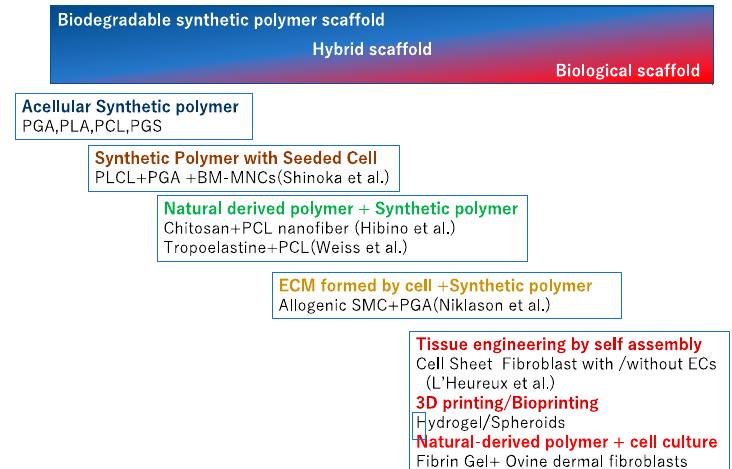
Figure 1. Graft classification by scaffold materials in animal model and clinical studies. Various combinations of biological-based scaffolds and biodegradable synthetic-based scaffolds have been developed and evaluated in large animal models and clinical studies. BM-MNCs, bone marrow mononuclear cells; EC, endothelial cell; PCL, poly ( ε -caprolactone); PGA, polyglycolic acid; PLA, poly (lactic acid); PGS, poly (glycerol) sebacate; SMC, smooth muscle cells.